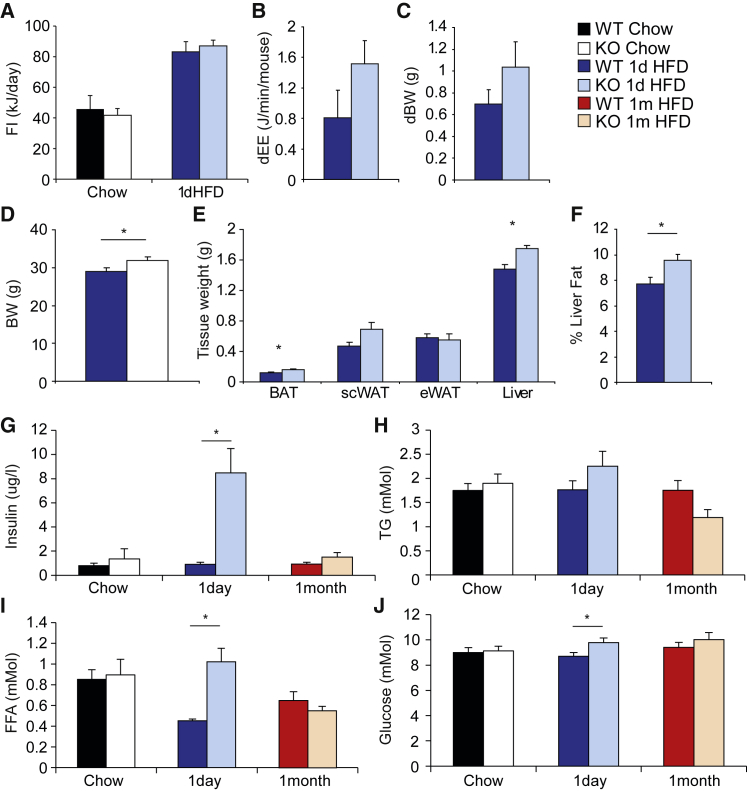
PPARγ2-KO Mice Exhibited Impaired Metabolic Responses to Acute Overfeeding(A–F) Responses to 1 day high-fat diet (1dHFD): (A) food intake, (B) change in energy expenditure (dEE), and (C) change in body weight (dBW) between chow and after 1dHFD; (D) body weight, (E) tissue weights, and (F) liver fat percentage after 1dHFD period.(G–J) Serum biochemistry for (G) insulin, (H) TGs, (I) FFAs, and (J) glucose after 1dHFD.N = 8 per group except 1 month HFD KO and food intake for chow and 1dHFD WT (n = 6). ∗p < 0.05, two-tailed Student’s t test. All mice were 4 months of age. All data are represented as mean ± SEM. See also Figures S1 and S2.